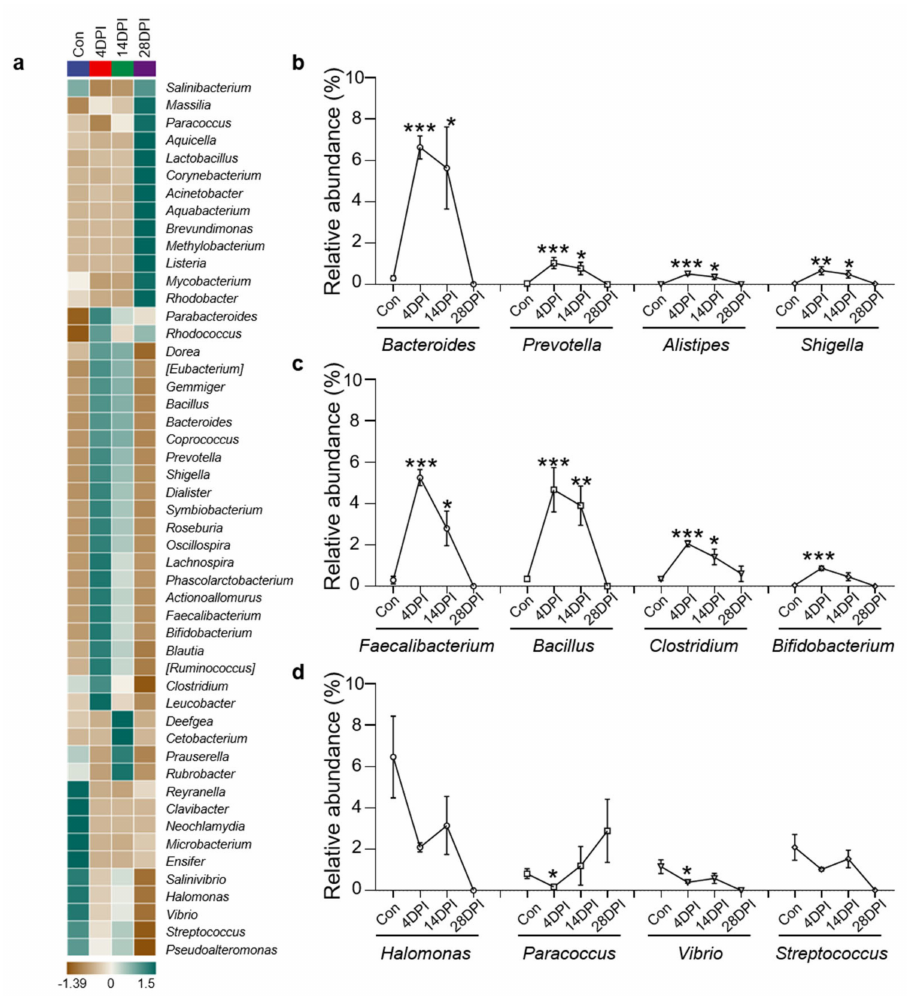
Figure 5. Changes of gut bacterial genera in response to IHNV infection. ( a ) Heatmap compared the composition of the top 50 genera with average abundance in different groups in the gut of rainbow trout. ( b ) Relative abundance of Bacteroides , Prevotella , Alistipes , and Shigella in the gut of rainbow trout in control and IHNV − infected groups of 4, 14, and 28 DPI. ( c ) Relative abundance of Faecalibacterium , Bacillus , Clostridium , and Bifidobacterium in the gut of rainbow trout in control and IHNV − infected groups of 4, 14, and 28 DPI. ( d ) Relative abundance of Halomonas , Paracoccus , Vibrio , and Streptococcus in the gut of rainbow trout in control and IHNV − infected groups of 4, 14, and 28 DPI. (*) p < 0.05, (**) p < 0.01, (***) p < 0.001 (unpaired Student’s t −